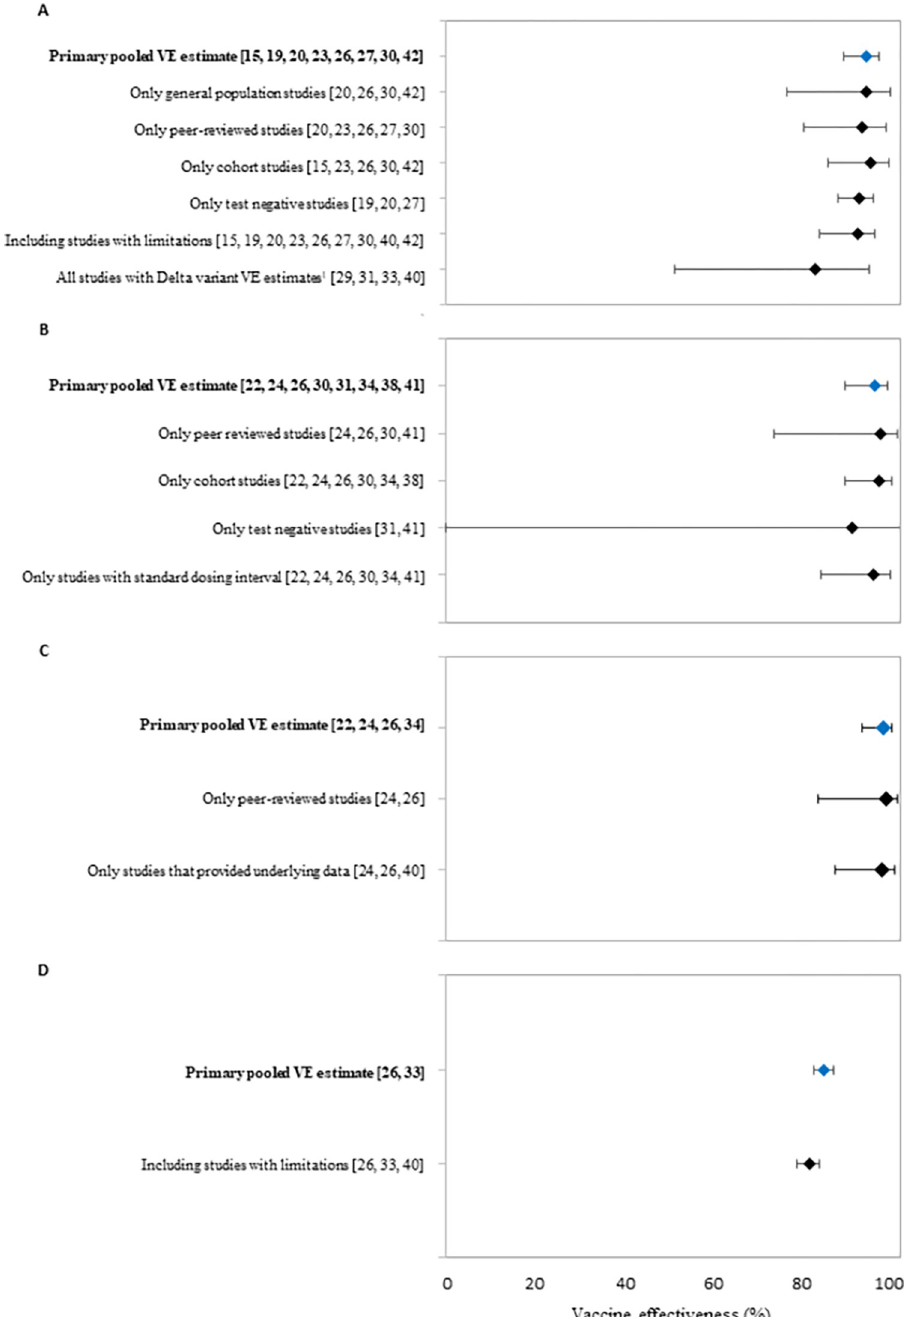
Fig 3. Forest plots showing primary pooled vaccine effectiveness estimates and estimates from sensitivity analyses for (A) symptomatic PCR-confirmed COVID-19; (B) hospitalization due to COVID-19; (C) death due to COVID-19; and (D) asymptomatic SARS-CoV-2 infection. Pooled vaccine effectiveness estimates were derived from random effects meta-analyses (A-C) or fixed effects meta-analysis (D). Values for pooled effectiveness estimates and heterogeneity are shown in supplementary tables. 1 Three studies provided a Delta-specific estimates [29, 31, 40] and one provided an estimate for the Delta-dominant period [33].